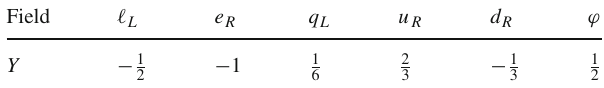
Table 5 Hypercharge assignments